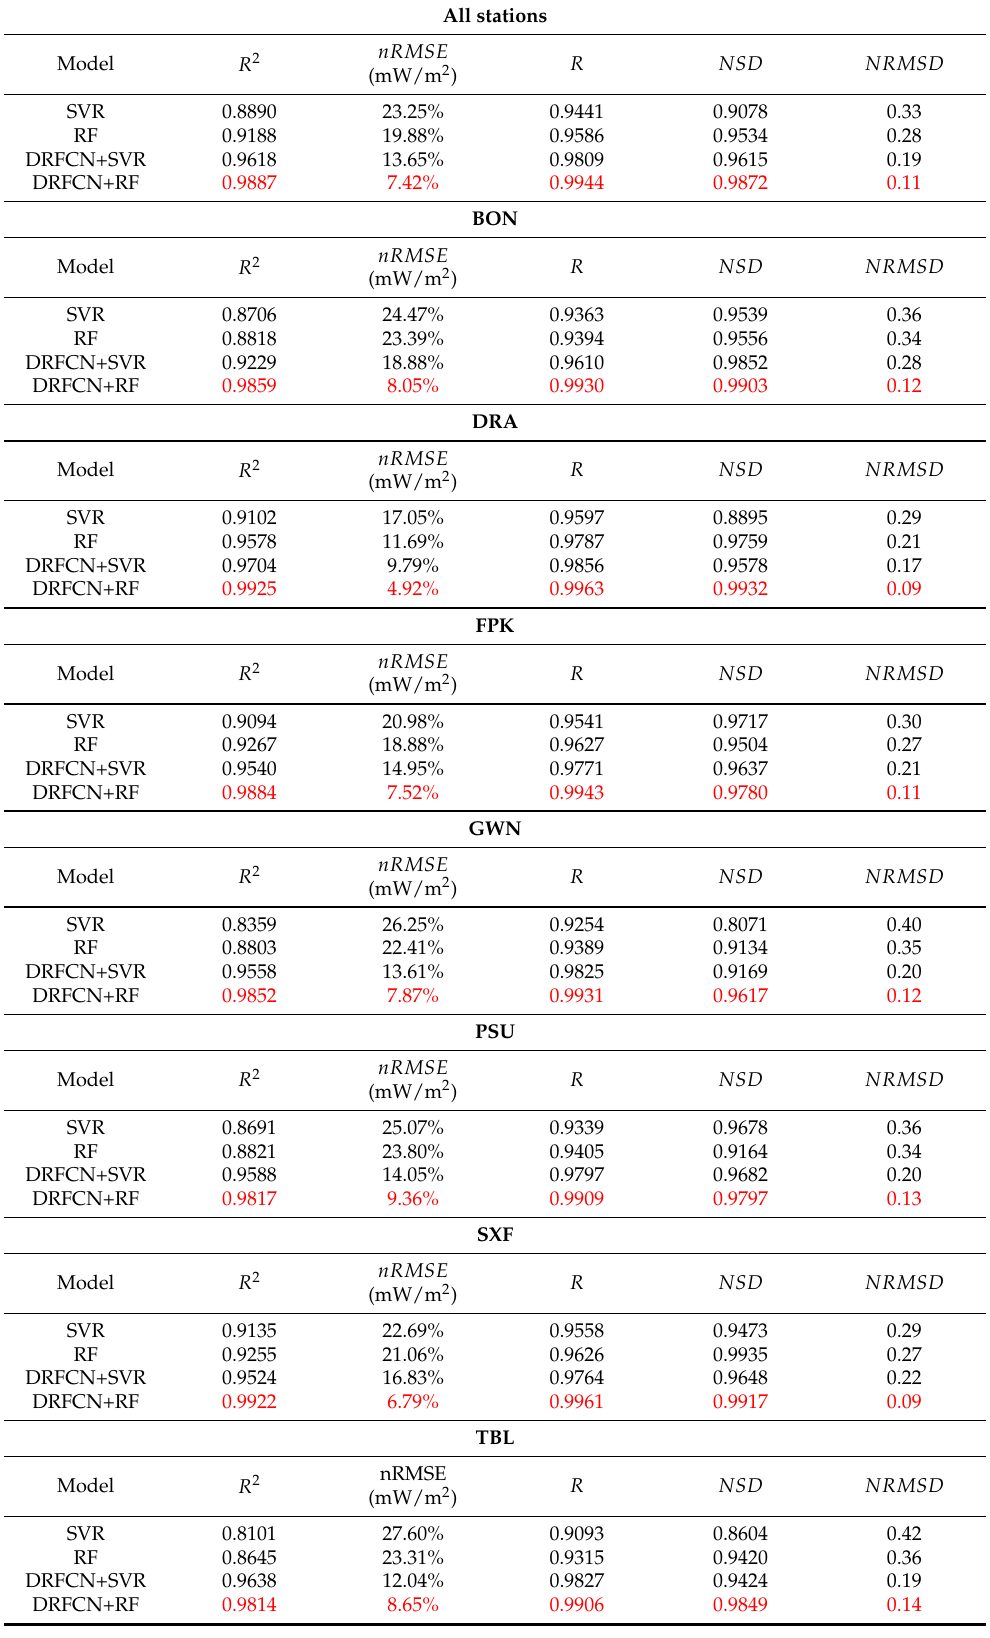
Table 4. Performance evaluation of the support vector regression (SVR), RF, DRFCN+RF, and DRFCN+SVR models by R 2 , nRMSE , R , NSD , and NRMSD . The best model is marked in